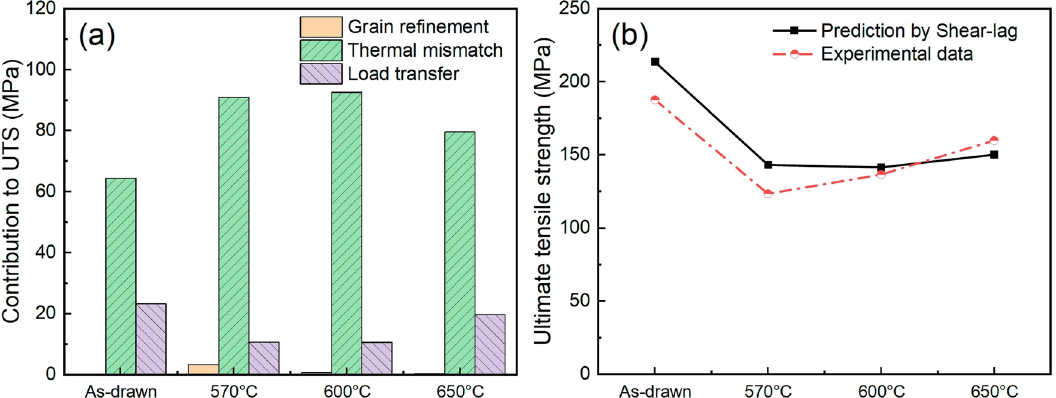
Figure 9: Evaluation of calculated strengthening mechanism of UTS in fabricating 2 wt% of GNP/Al composite. ( a ) Comparison of each strengthening mechanism and ( b ) calculated UTS predicted by shear lag mechanism ( load transfer ) against experimental data. Reproduced from ref. [ 66 ]